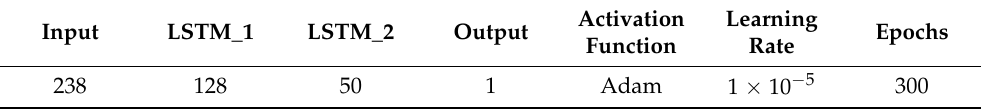
Table 4. Parameter settings of the proposed method.